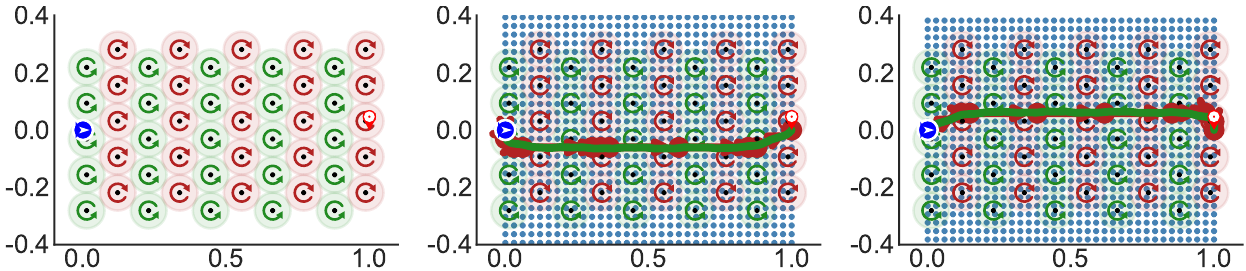
0.0 Figure 5. Test problem (d) with 50 vortices (10 columns of 5 vortices each), R = 1/16, regularly positioned. x O = [ 0,0 ] T , x D = [ 1,0 ] T , ¯ w = 0.5 ¯ v . Blue dots: graph with h = l 2 and 1/ h x = 33 and 34, respectively, red: discrete optimal trajectory, green: continuous optimal trajectory. Note that, again, the straight trajectory is particularly unfavorable. This problem is point-symmetric w.r.t. [ 0.5,0 ] T . The two shown solutions are